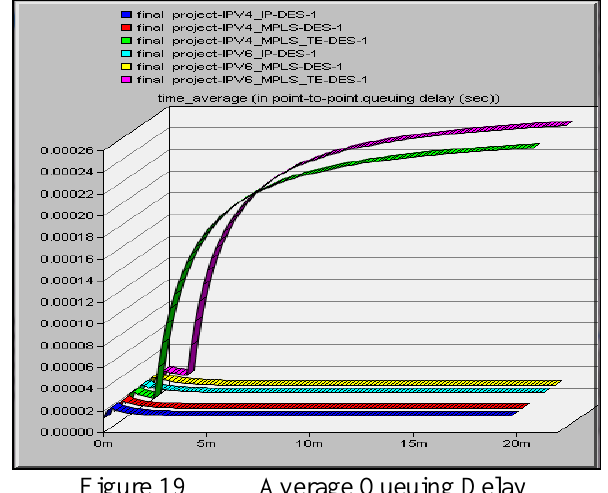
Figure 19 Average Queuing Delay Comparison along alternate path